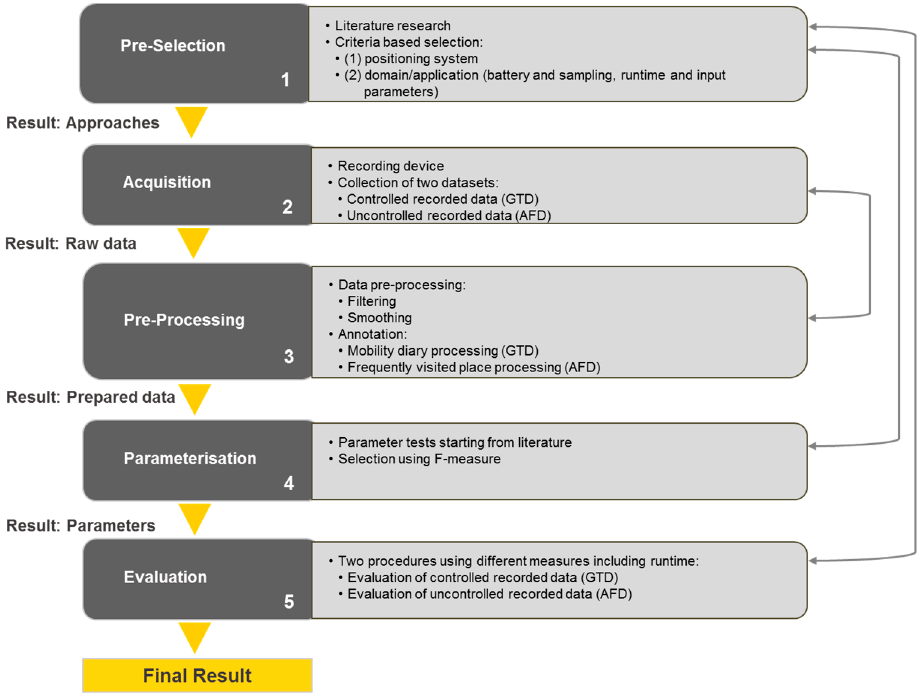
Figure 1. Stay detection evaluation framework.